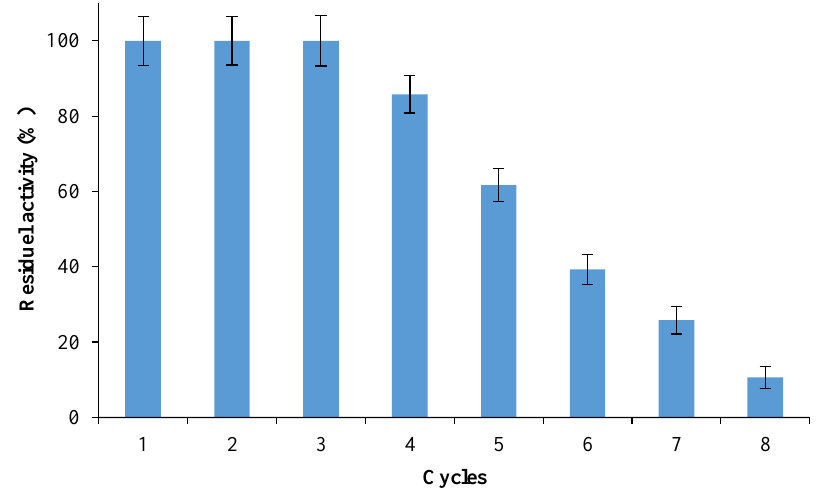
Figure 10. Re-usability of lipase immobilized Fe 3 O 4 nanoparticles.